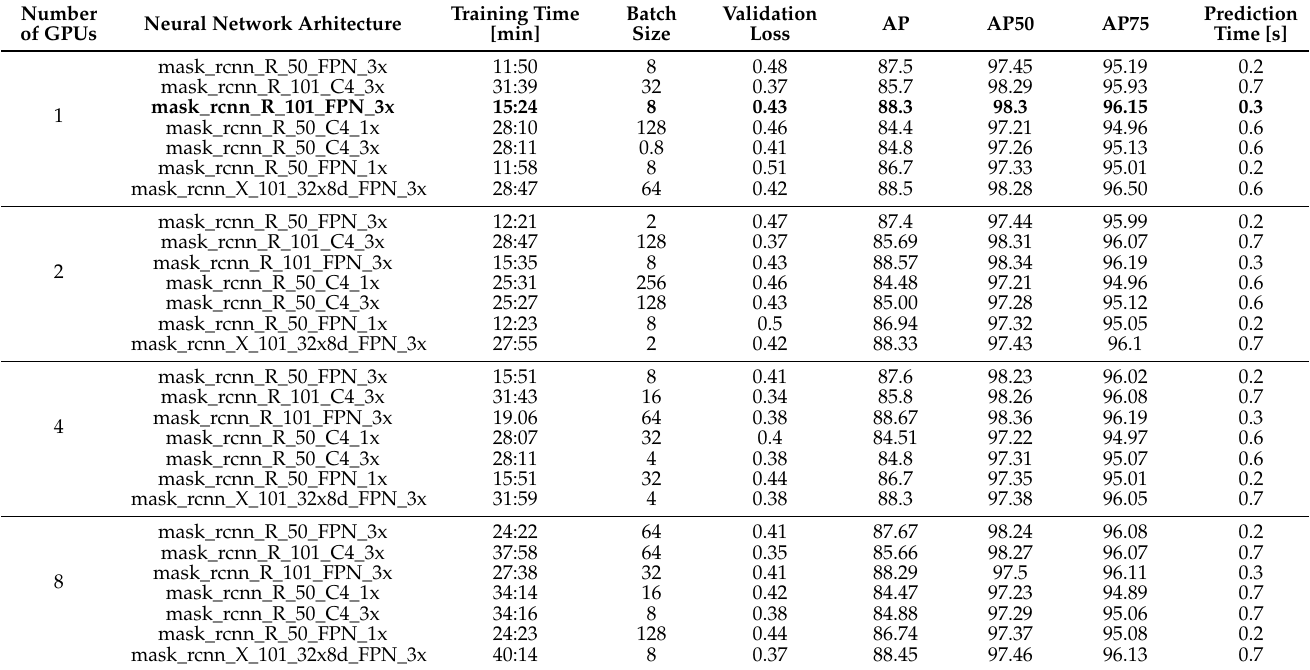
Table 3. Instance segmentation evaluation of different Mask R-CNN network architectures in Detec- tron2, gamma = 0.5 and steps = 1000.